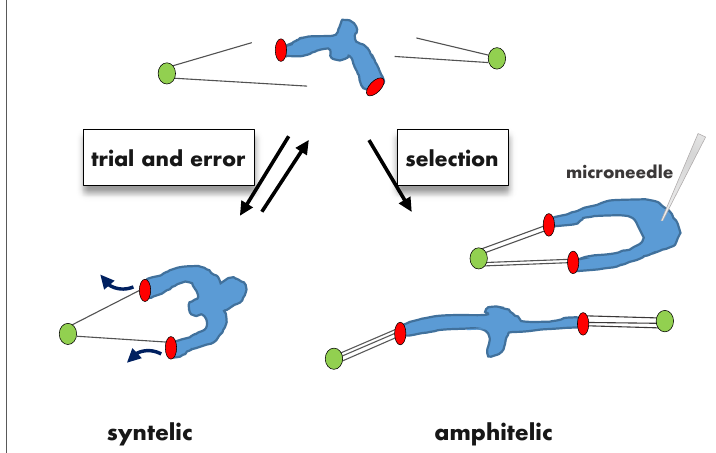
Figure 1. Tension-dependent error correction for syntelic kinetochore microtubule (KMT) attachments. Kinetochores (red) of a meiotic bivalent (blue) repeatedly bind MTs from different poles (green), but KMT attachments in the syntelic configuration are short-lived. Tension arises when the amphitelic configuration is encountered, inducing stable KMT attachments. Syntelic attachments can be stabilized artificially by applying tension with a microneedle. In meiosis I, as shown here, kinetochores of homologous chromosomes attach to opposite spindle poles in the amphitelic orientation. In mitotic cells, kinetochores of sister chromatids would attach to opposite